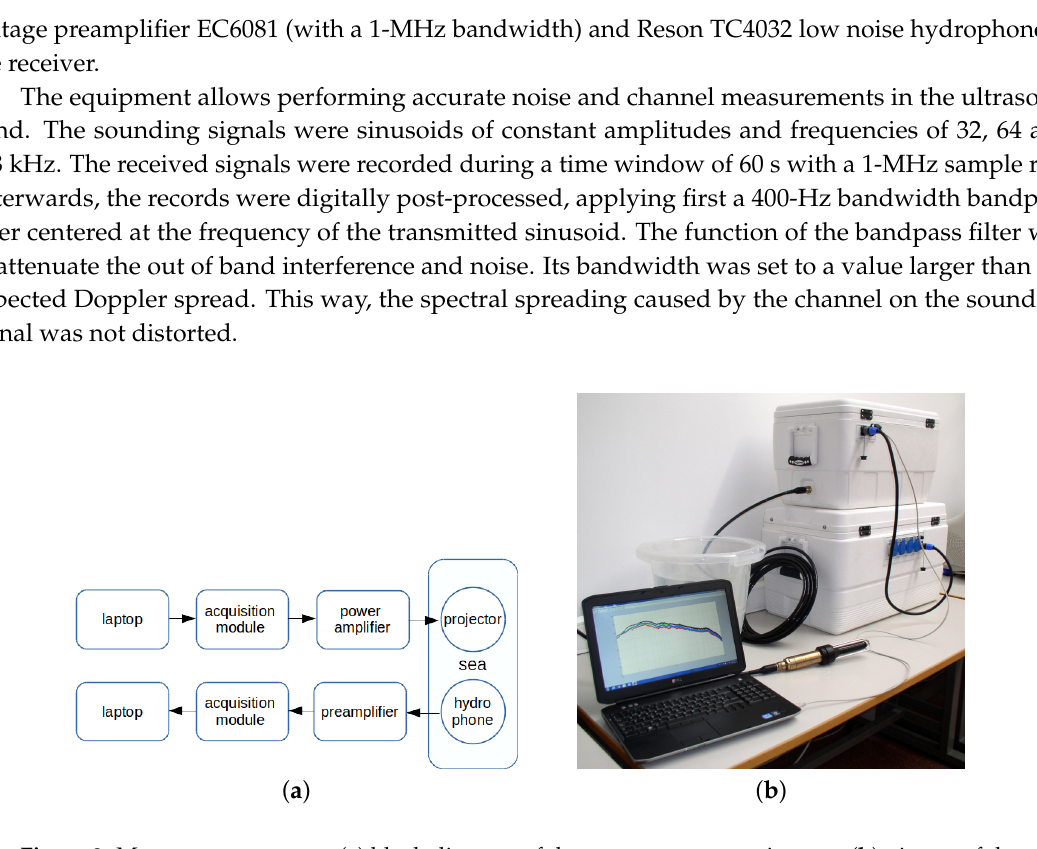
Figure 2. Measurements setup: ( a ) block diagram of the measurement equipment; ( b ) picture of the receiver part at the laboratory.